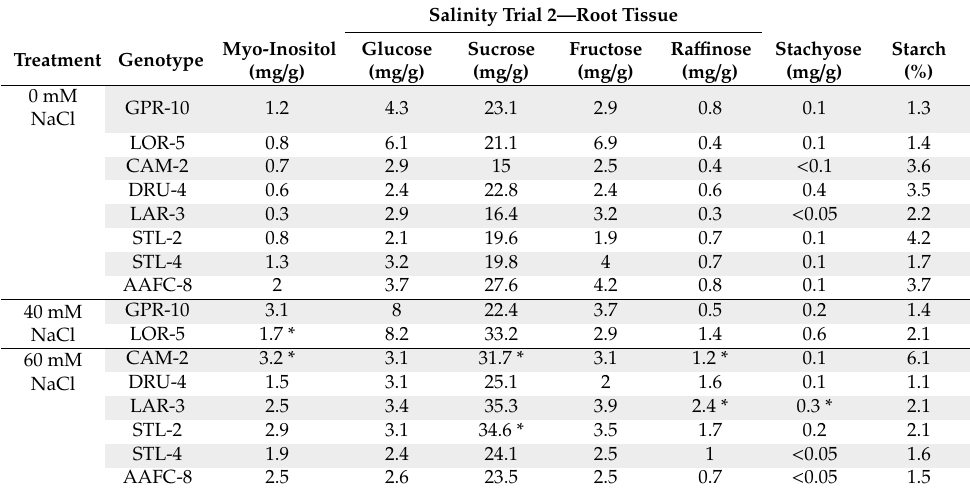
Table 4. Soluble sugar and starch contents in poplar, willow, hybrid willow root tissues at the conclusion of the second salinity trial. Willow and hybrid roots were analyzed at 0 and 60 mM NaCl, and poplar roots at 0 and 40 mM NaCl due to limitations of available root tissue ( n = 3 for each genotype and treatment). Asterisks denote significant di ff erence from control treatment ( p < 0.05).